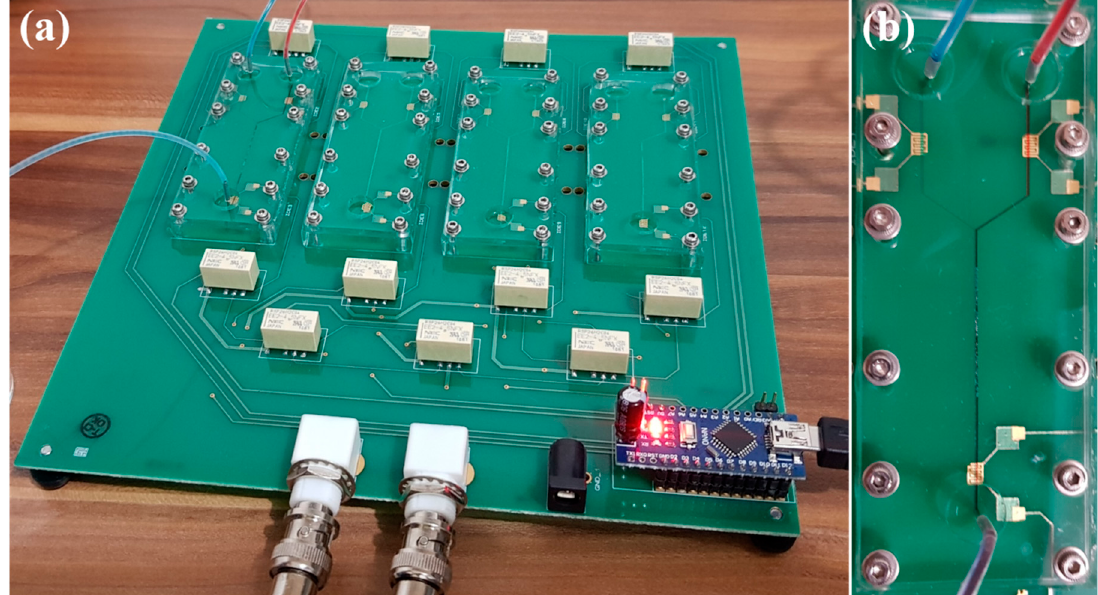
Figure 3. ( a ) Printed circuit boards (PCB) embedding four sensing units (three electrodes for each Y-shaped microchannel = 12 electrodes) in a single automated platform. ( b ) Zoom at one Y-shaped microchannel with a staggered herringbone mixer (SHM) incorporating interdigitated electrodes (IDEs) at the device inputs (before mixing: blue/red dyes) and output (after mixing: purple mixture).